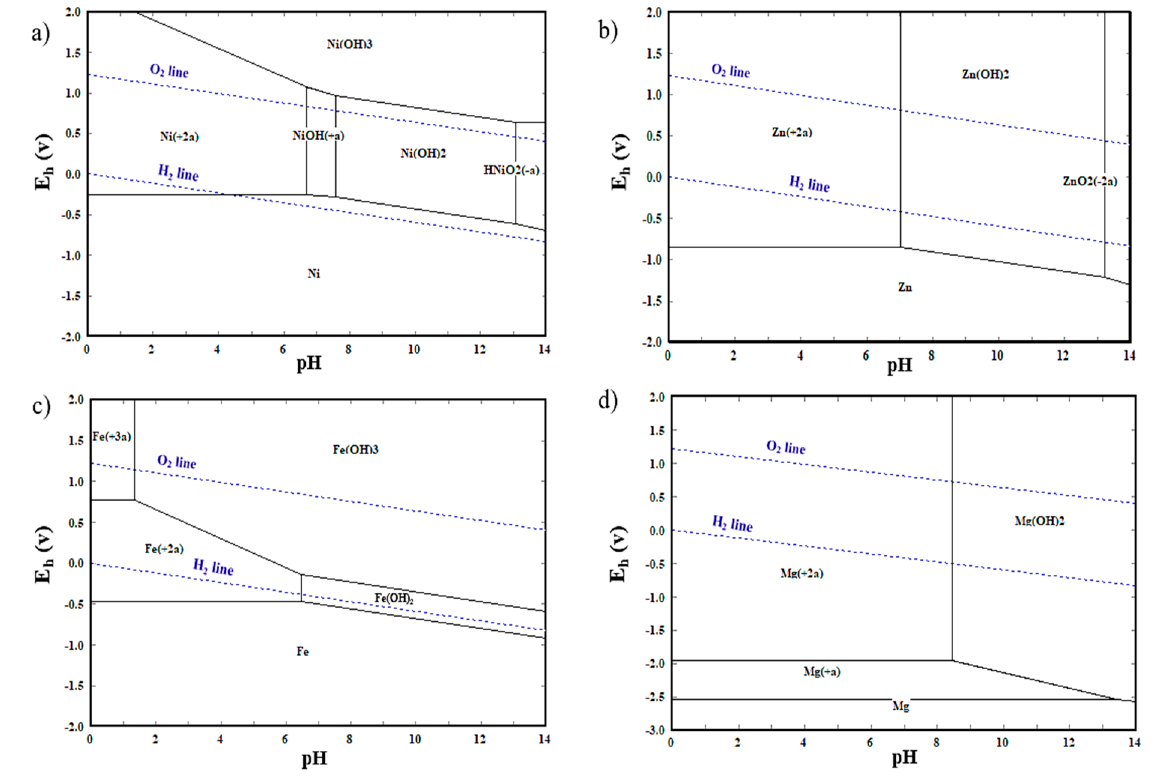
Figure 6. Eh–pH diagrams of Ni-H 2 O system ( a ), Zn-H 2 O system ( b ), Fe-H 2 O system ( c ) and Mg-H 2 O system ( d ) at 25 °C, where all the concentrations of Zn, Ni, Fe and Mg are 1 mol/L. Table 3. Chemical composition of the leachate (g.L –1 ).